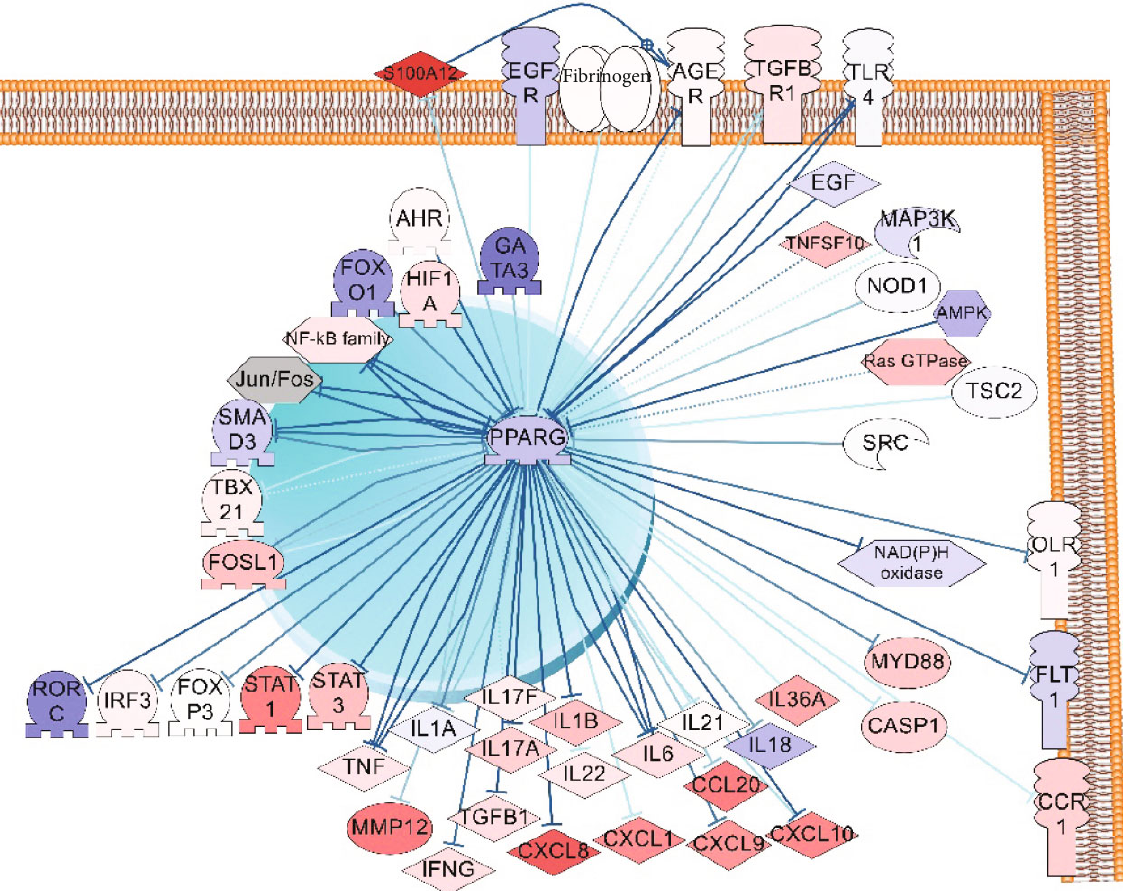
Figure 6: Evaluation of PPAR γ -downregulated subnetwork (selected PPAR γ regulators and targets) associated with psoriasis using microarray data analysis (results of di ff erential expression analysis of psoriatic lesions vs. unaltered lesions). The saturation in blue indicates the degree of gene downexpression in psoriatic samples in comparison with unaltered samples. The saturation in red indicates the degree of gene overexpression. The list of targets and regulators can be seen in supplemental materials, “ PPARG regulators and targets, ” list